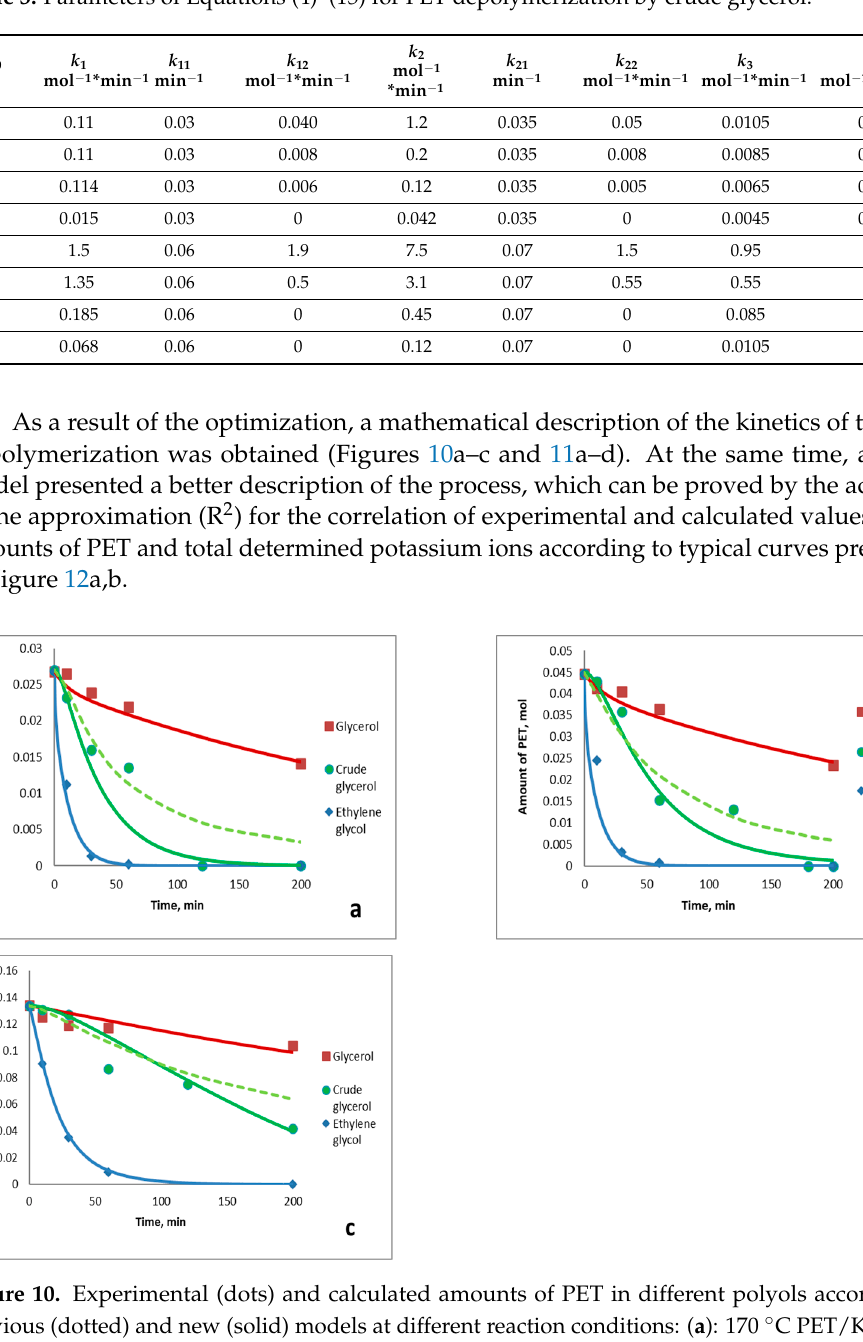
Figure 11. Experimental (dots) and calculated amounts of PET and potassium compounds in crude glycerol according to the previous (dotted) and new (solid) models at different reaction conditions: ( a ) 190° PET/KSt = 0.4; ( b ) 190° PET/KSt = 0.5; ( c ) 190° PET/KSt = 1.0; ( d ) 190° PET/KSt = 1.5. Figure 12. Correlation between calculated and experimental amounts of PET and total potassium ions at PET/KSt = 1.5 molar ratio and different reaction conditions: ( a ) in different polyols at 170 °C; ( b ) in crude glycerol at 190 °C.